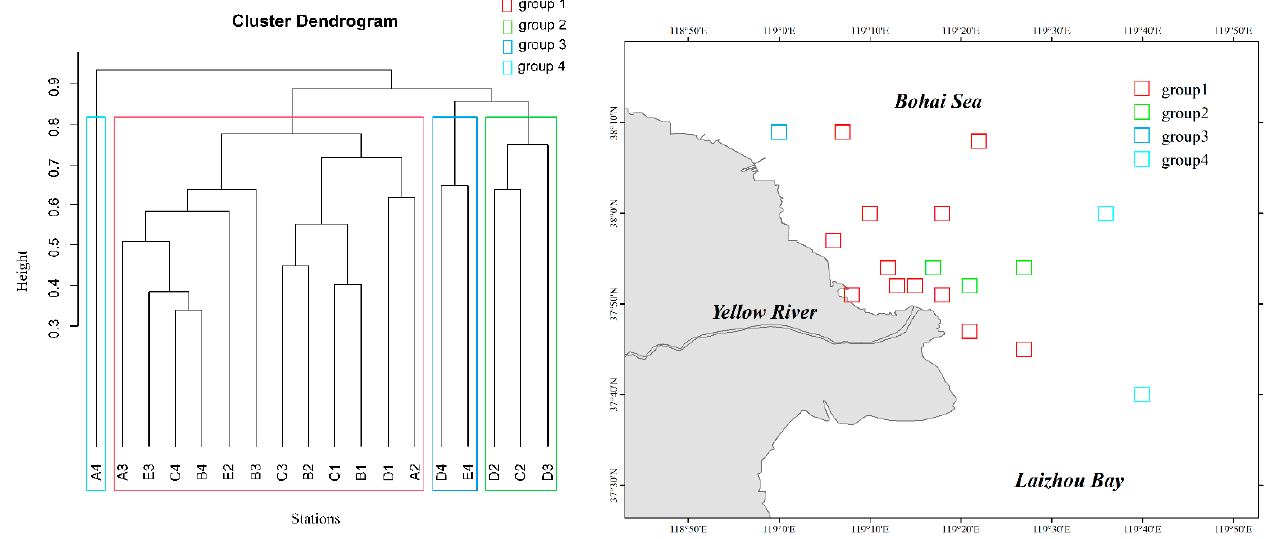
Figure 6. Cluster analysis of community structures of fish eggs and larvae in the Yellow River estuary across seasons.